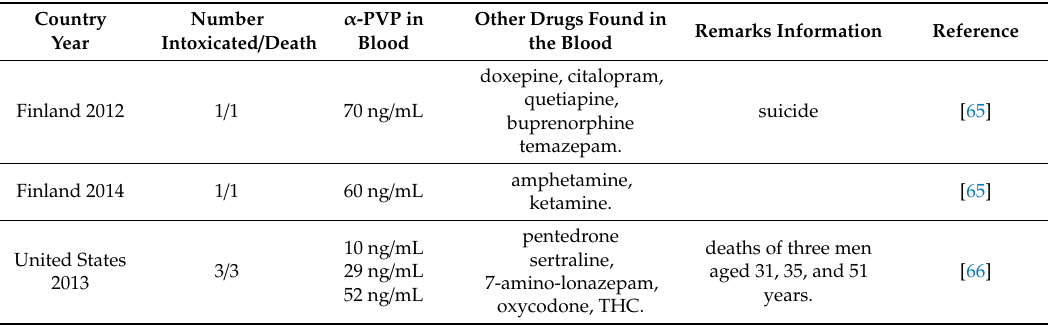
Table 1. Fatalities after α -PVP application published in medical